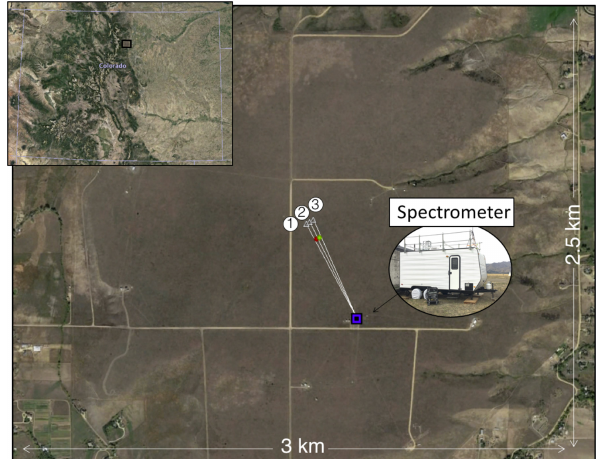
Figure 3. Map view of observation test site at Table Mountain, Col- orado (upper left inset shows geographic location of test site), with two source locations (location 1, in red, between beams 1 and 2; lo- cation 2, in green, between beams 2 and 3) and three beams shown as white lines that extend from the spectrometer (blue square) to retroreflectors (white triangles, labeled